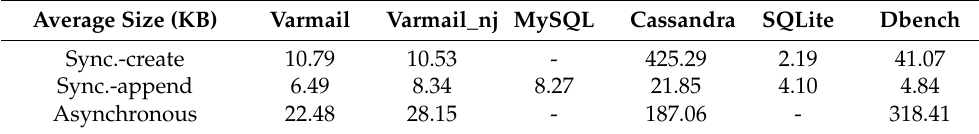
Table 4. Size characteristics of data write requests.